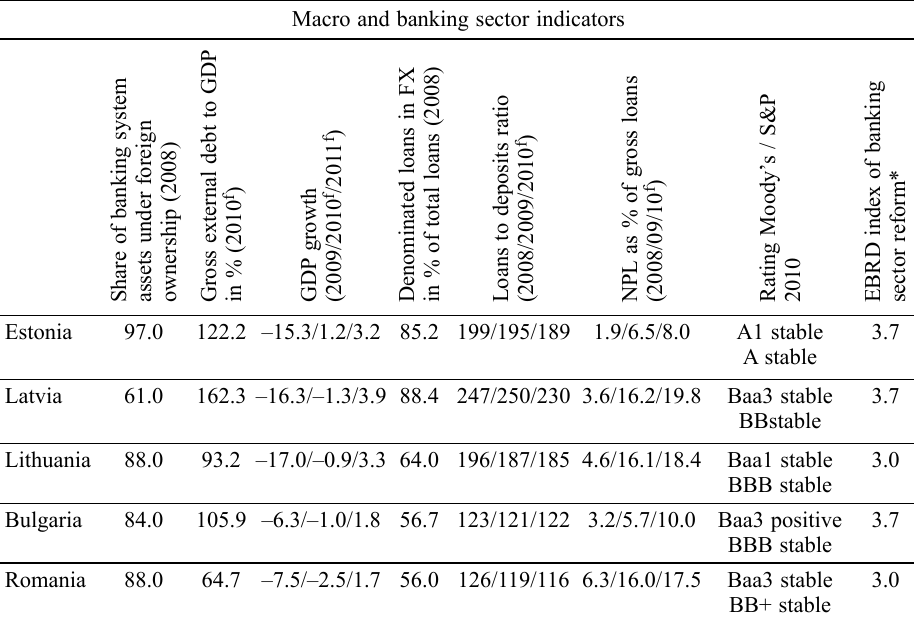
Table 1. Macro and banking sector indicators for the NMS-5 3 Macro and banking sector